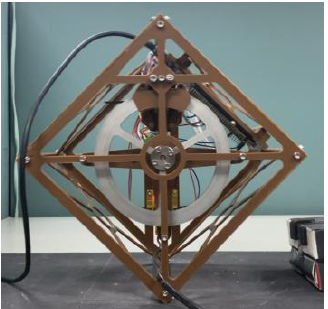
Figure 1. The prototype of the cube robot balancing on its edge.